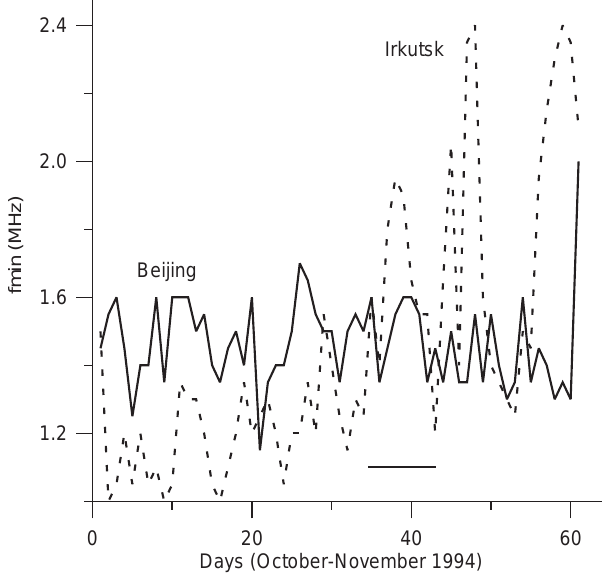
Fig. 2. Parameter f from Beijing ( solid line ) and Irkutsk ( dashed min line ) during October–November, 1994 (days 1–61). Short horizontal line , interval of the CRISTA/MAHRSI experiment